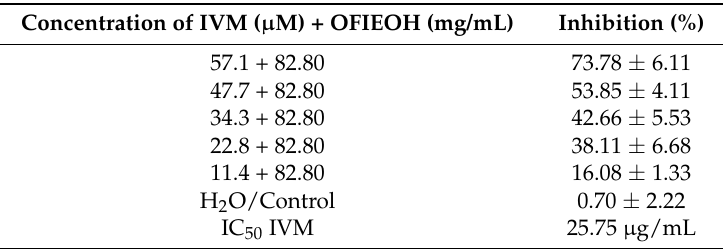
Table 4. Percentage ( ± standard deviation) of inhibition of migration of gastrointestinal nematodes using the larval migration test with the interaction of ivermectin and the concentration equivalent to the IC 50 of Opuntia ficus-indica essential oil (OFIEOH).